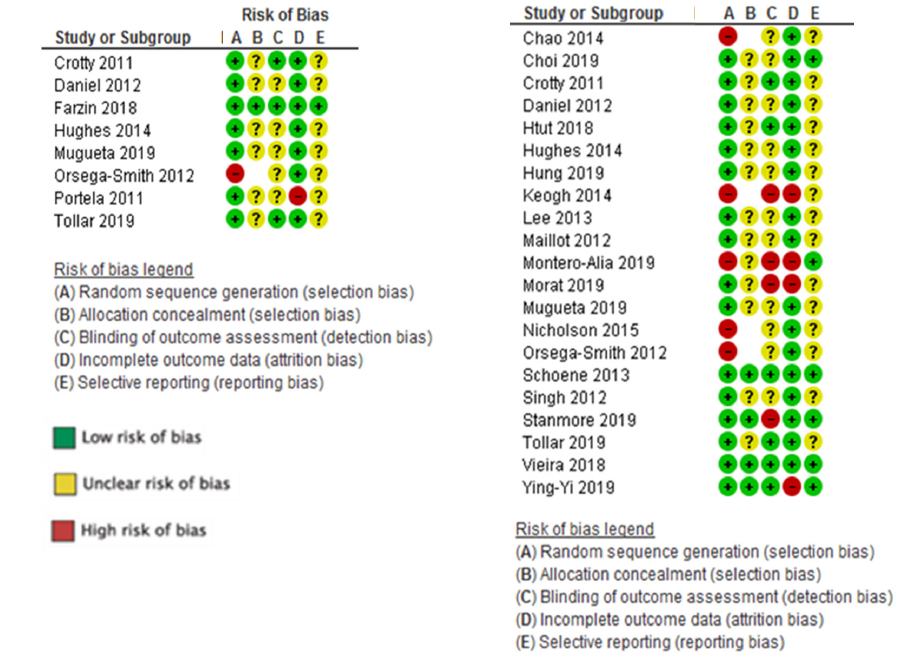
Int. J. Environ. Res. Public Health 2020 , 17 , x FOR PEER REVIEW Figure 3. Risk of bias ADL studies, Risk of bias functional mobility studies. Figure 3. Risk of bias ADL studies, Risk of bias functional mobility studies.